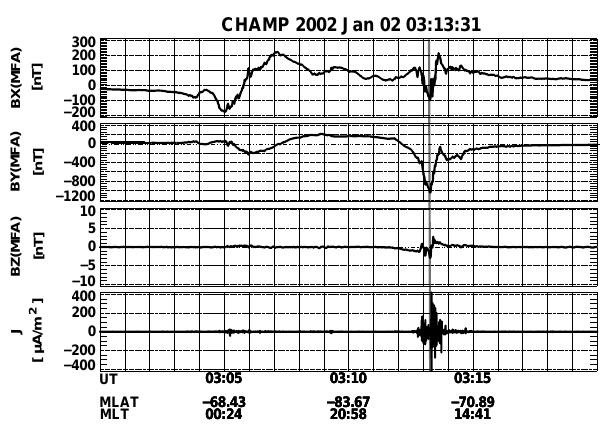
Fig. 1. Examplecase of high resolutionCHAMP Fluxgate Magnetometer data in a Mean Field Aligned coor- Fig. 1. Example case of high resolution CHAMP Fluxgate Magne- dinatesystem(upperthreepanels)andderivedsmall-scalefield-aligned currentdensity(lowestpanel). tometer data in a mean field-aligned coordinate system (upper three panels) and a derived small-scale field-aligned current density (low- est